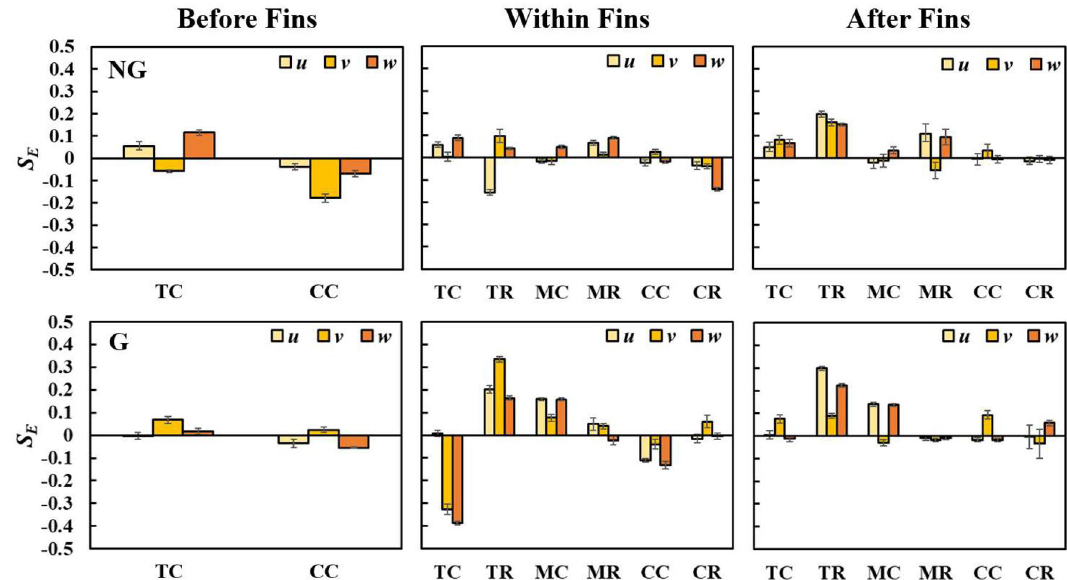
Figure 12. Equivalent skewness of velocity fluctuations along streamwise u , spanwise v and cross-stream w for NG (top row) and G (bottom